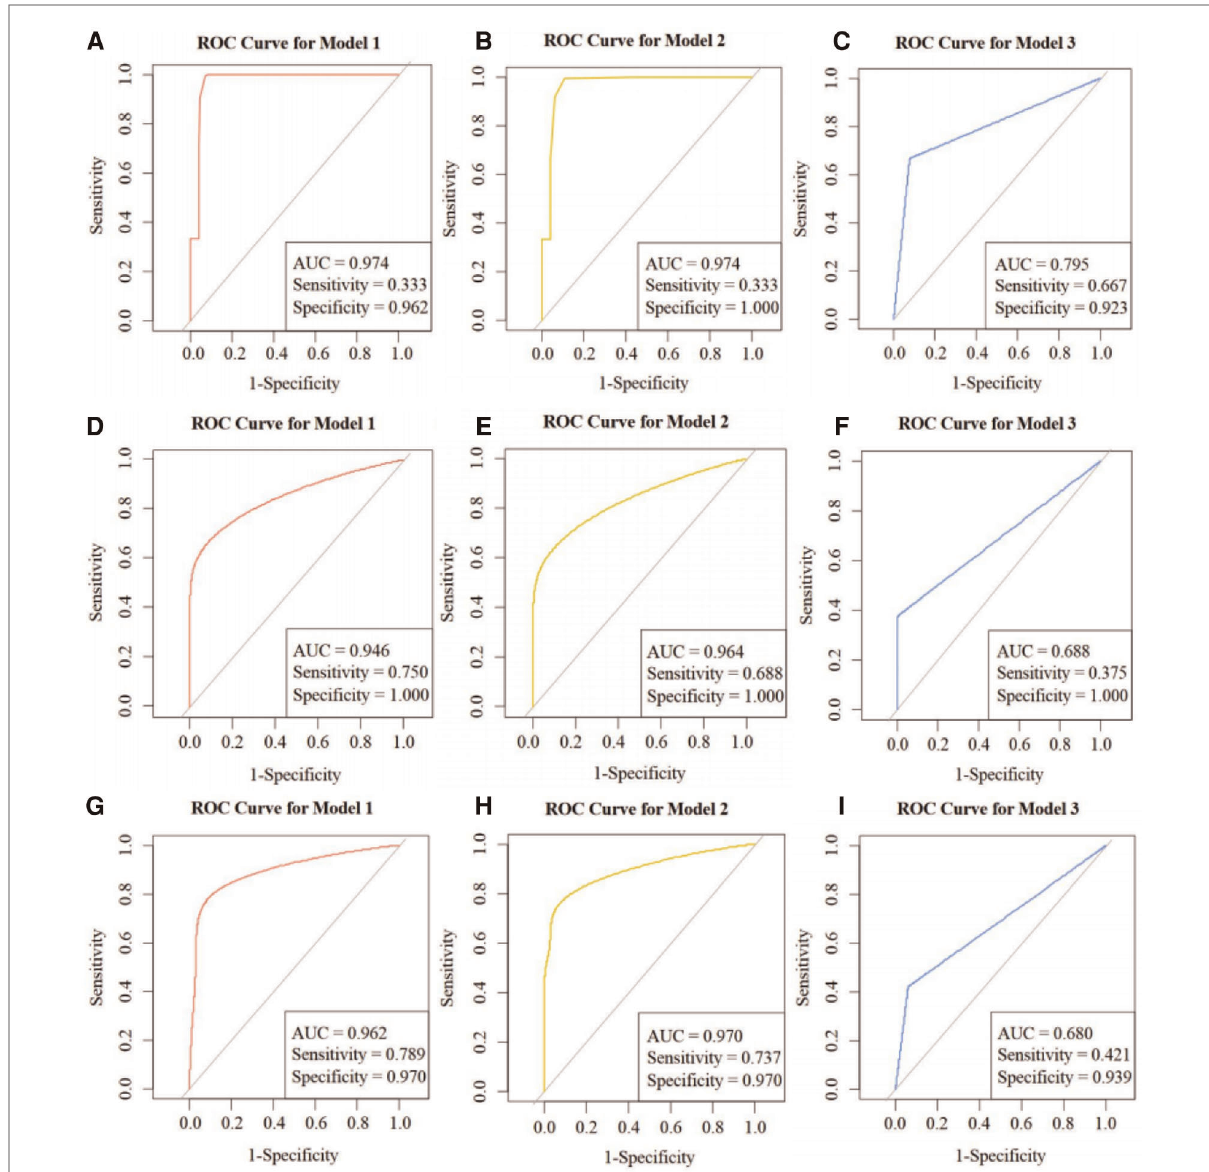
FIGURE 7 ROC curves: external validation. ROC, receiver operator characteristics; AUC, area under the curve. ( A ), ( B ), and ( C ) are the ROC curves and AUC of Models 1, 2, and 3 in the external validation cohort respectively, including their sensitivity and speci fi city calculated using the cutoffs from the training cohort. ( D ), ( E ), and ( F ) are the calibration plots of the three models in the external validation cohort. ( G ), ( H ), and ( I ) are the ROC curves of Models 1, 2, and 3 in the external validation cohort, including their sensitivity and speci fi city calculated using the threshold